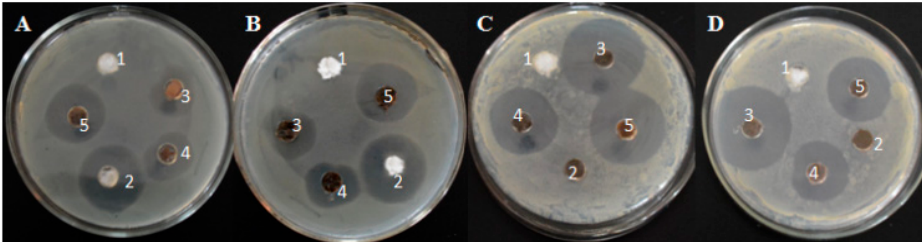
Figure 5. Representative images containing the inhibition zone of E. coli with 10 8 CFU/mL ( A , C ) and S. aureus with 10 8 CFU/mL ( B , D ). Samples A1–5 and B1–5 are silk fibers, silk fibers with Kanamycin,